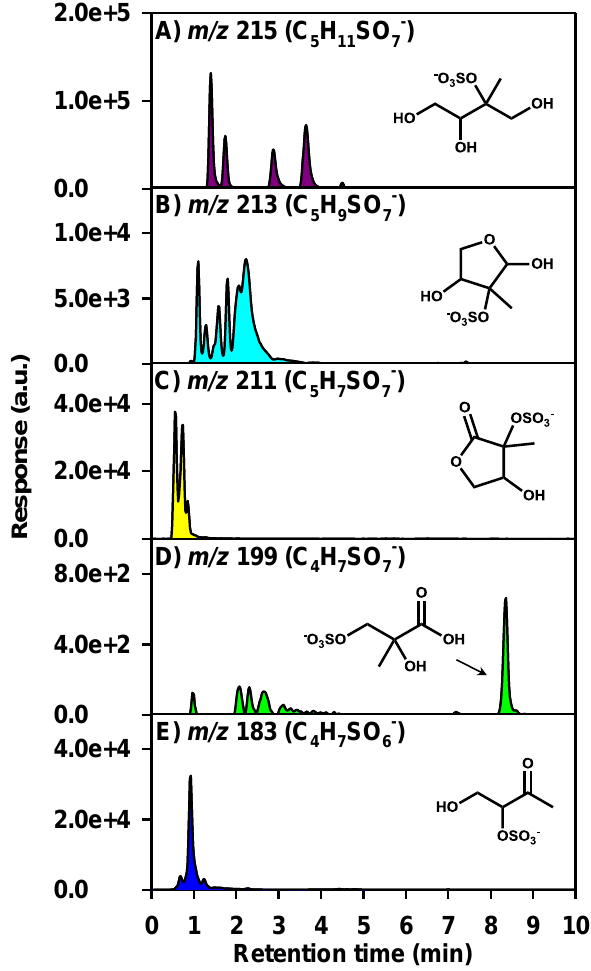
Figure 4. Extracted ion chromatograms and the proposed structures for organosulfates qualitatively identified in PM 2 . 5 collected dur- ing the daytime on 10 July 2013 in Centreville, AL using HR-MS: (a) C 5 H 11 O 7 S − ( m/z 215.0225), (b) C 5 H 9 O 7 S − ( m/z 213.0069), (c) C 5 H 7 O 7 S − ( m/z 210.9912), (d) C 4 H 7 O 7 S − ( m/z 198.9912), (e) C 4 H 7 O 6 S − ( m/z 182.9963) (smoothed 2 × 1; absolute window: ±